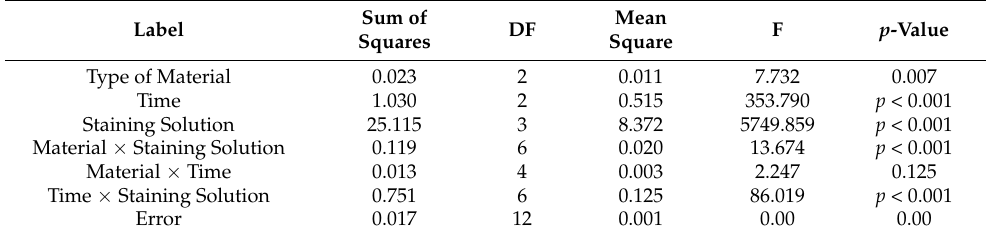
Table 5. Two-way ANOVA for ∆ E .